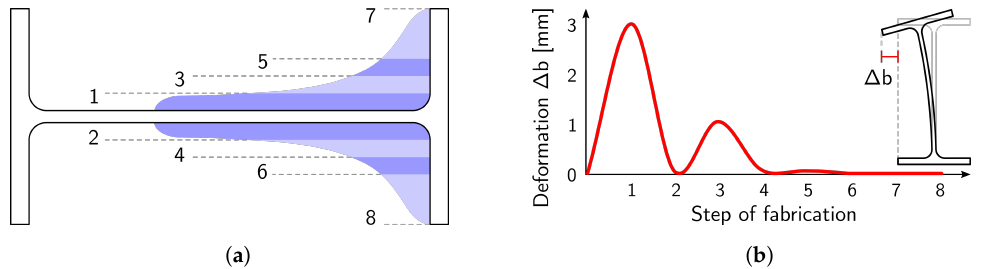
Figure 22. ( a ) Sequence (1-2-3-4-5-6-7-8) of fabrication steps using the example of IIa; ( b ) Exemplary representation of the deformation process during production of